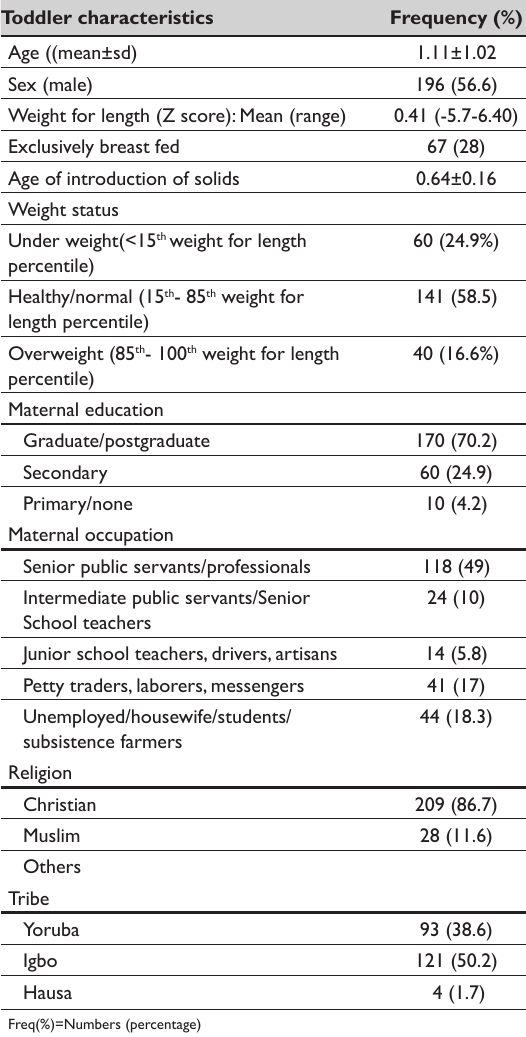
Table 1: Socio‑demographic characteristics of